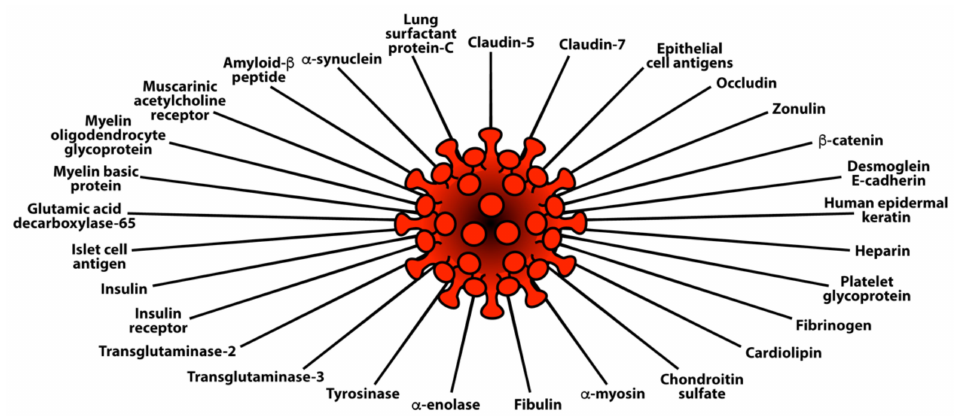
Figure 7. Elevations in IgA antibody against 29 different human tissue antigens in the blood of patients with mild to severe SARS-CoV-2 infection (positive for PCR and antibody) in comparison to healthy